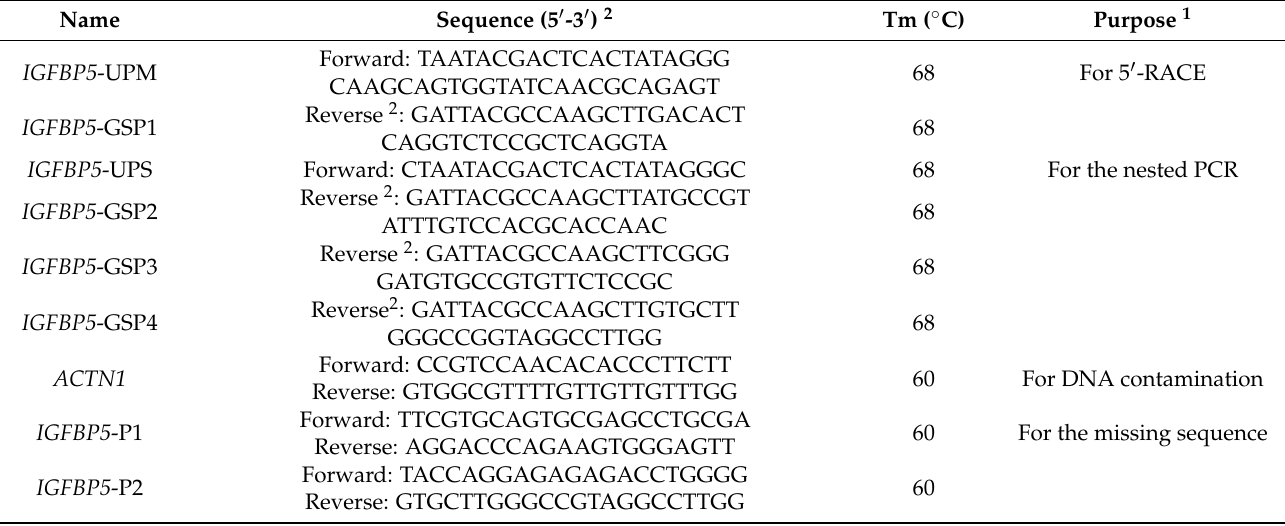
listed in Table 1, and the sequences of the primers used for qPCR are listed in Table 2. Genomic and mRNA sequences of the goose IGFBP5 gene (NW_013185861.1, XM_013196711.1, and a new sequence from this study) were used for primer design. Table 1. Information on the primers used in this study.